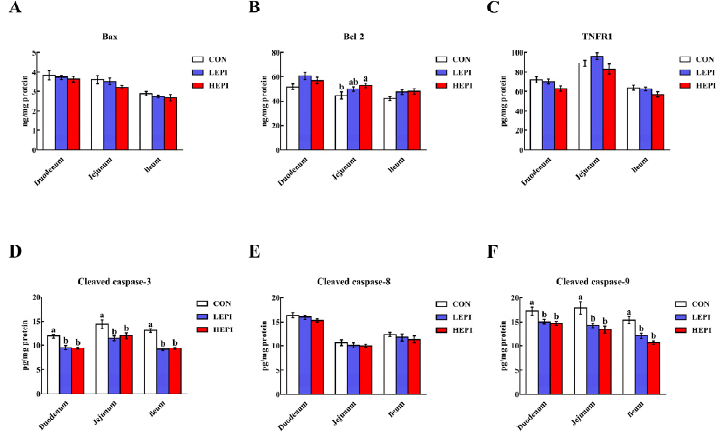
Figure 4. Effects of epicatechin on intestinal Bax ( A ), Bcl-2 ( B ), TNFR1 ( C ), cleaved caspase-3 ( D ), cleaved caspase-8 ( E ), and cleaved caspase-9 ( F ) contents in mice. Data are expressed as means